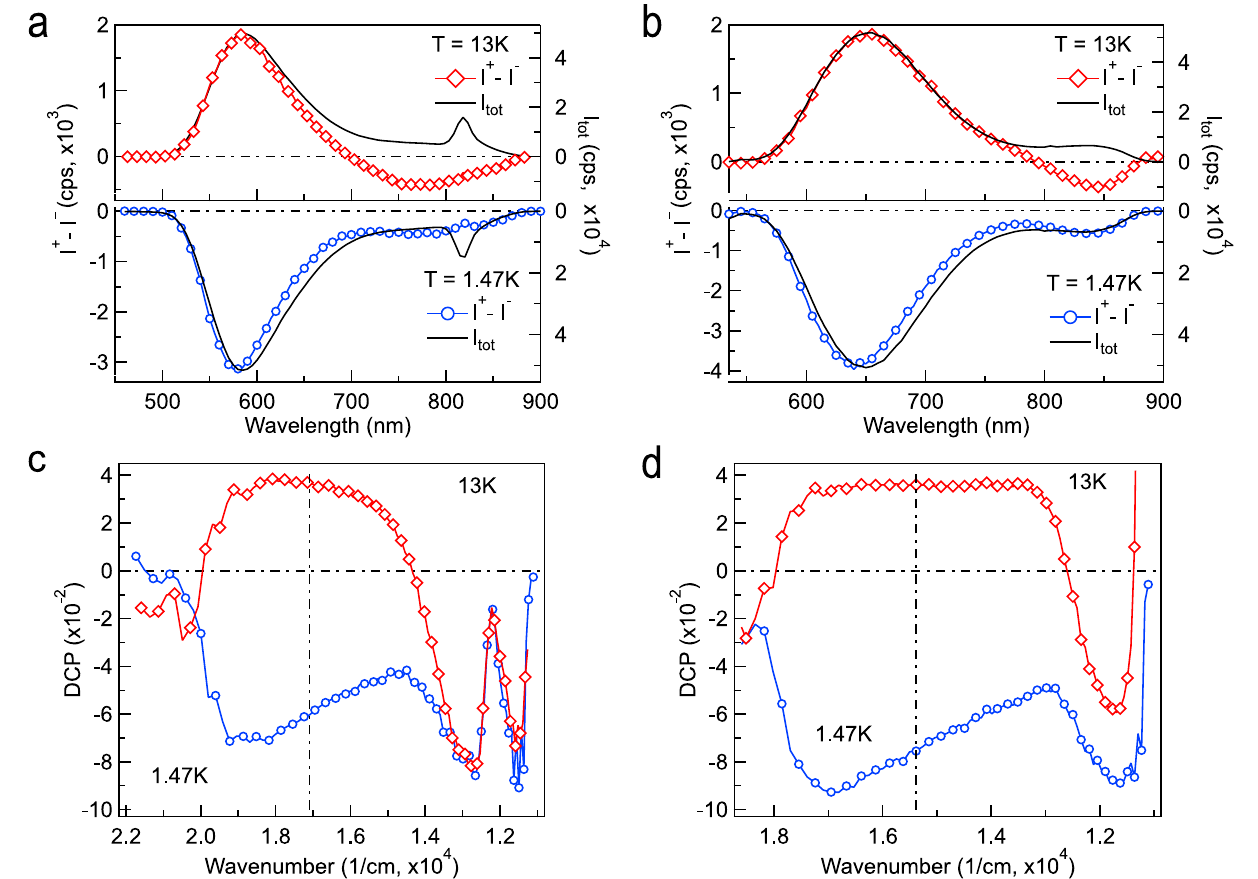
Figure 3. Comparison of MCPL ( I + − I − ) and total intensity spectra recorded upon excitation at 450 and 532 nm ( ( a ) vs ( b ) and ( c ) vs ( d )). Comparison of DCP ( I + − I − )/( I + + I − ) spectra recorded at temperatures of 1.47 and 13 K. Magnetic field is 6 T in all panels. Vertical dash-dot lines indicate the band maximum